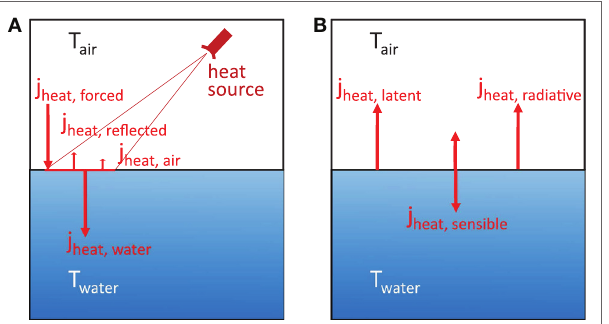
FigURe 3 | (A) Schematic representation of the controlled flux technique. An external heat source is used to heat the water surface and to apply a heat flux density. A small fraction of the incoming heat flux density is reflected. As the main resistance for heat transport lies on the air side, most of the heat flux will go into the water. (B) Heat fluxes at the water surface without external forcing.